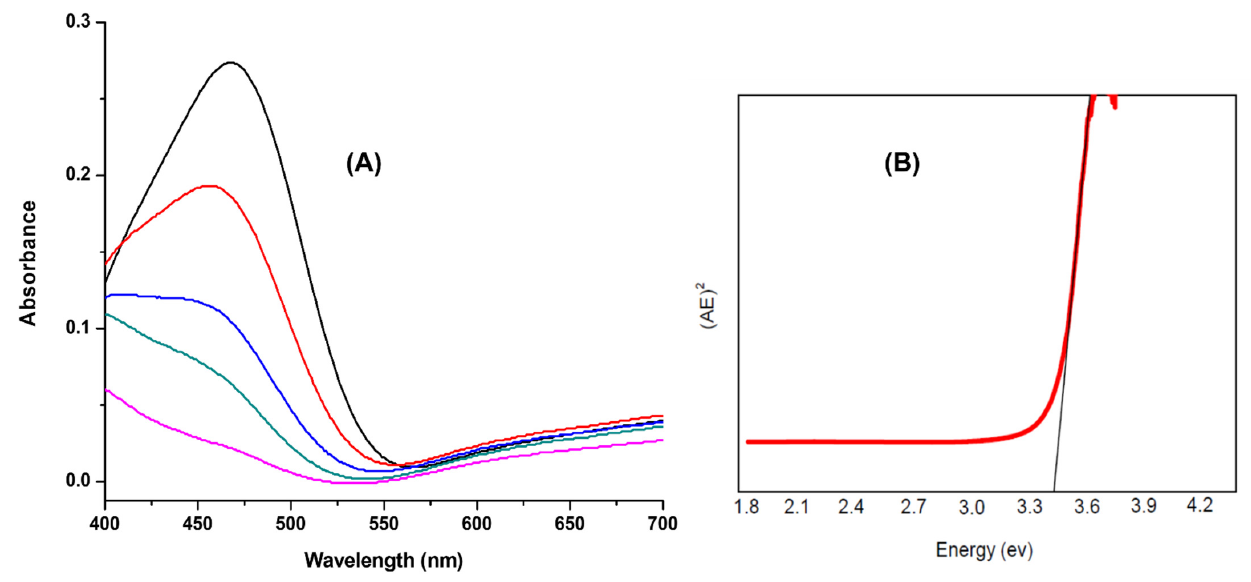
Figure 6. ( A ) Photocatalytic activity performance measures for ZnO/CuO nanocomposite, as a function of time (0, 15, 30, 45, 60) min (from pink to black line, respectively). ( B ) Corresponding Tauc plot for bandgap calculation.